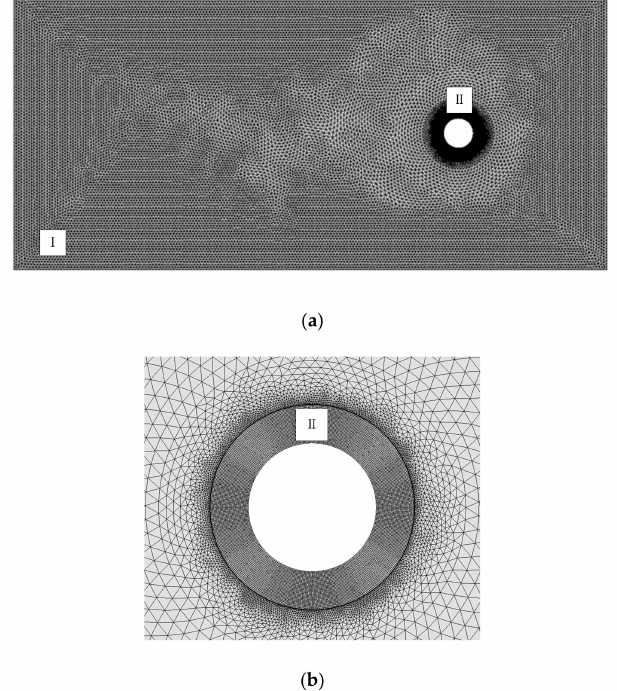
Figure 2. Sketch of the computational domain (I is the dynamic mesh zone; II is the accompanying moving zone): ( a ) the whole computational zone; ( b ) the mesh near the cylinder. Table 1. The e ff ect of the grid number on the lift and drag coe ffi cients ( ∆ t = 0.0001 s). Initial N m